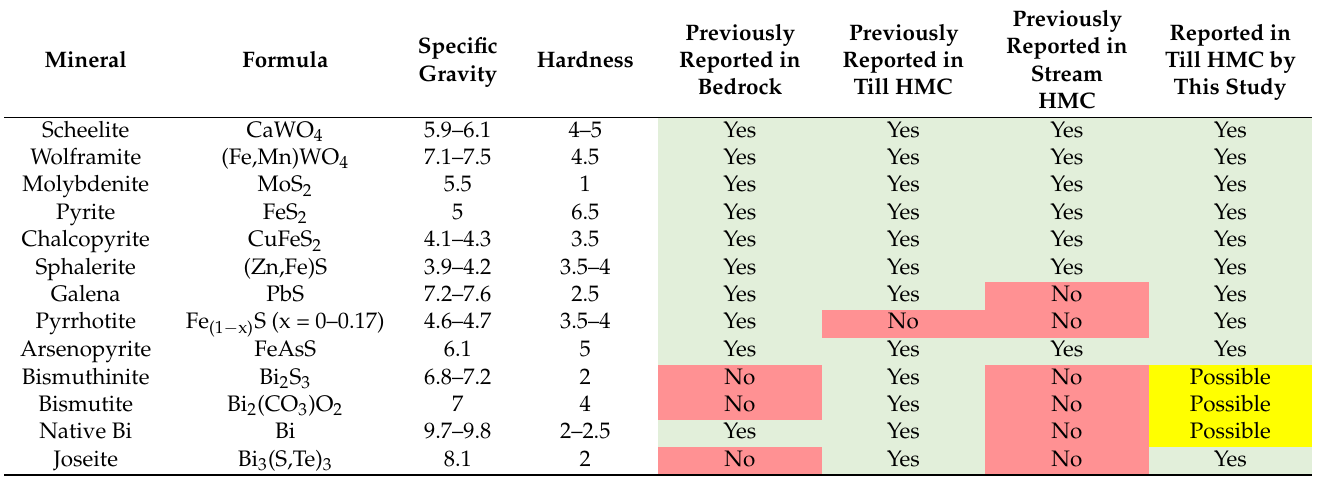
Table 2. Potential indicator minerals of the Sisson W-Mo deposit, as reported by McClenaghan et al. [21] and this study. Yellow shaded “possible” minerals could potentially be present as part of the “Bi-mineral” population identified by